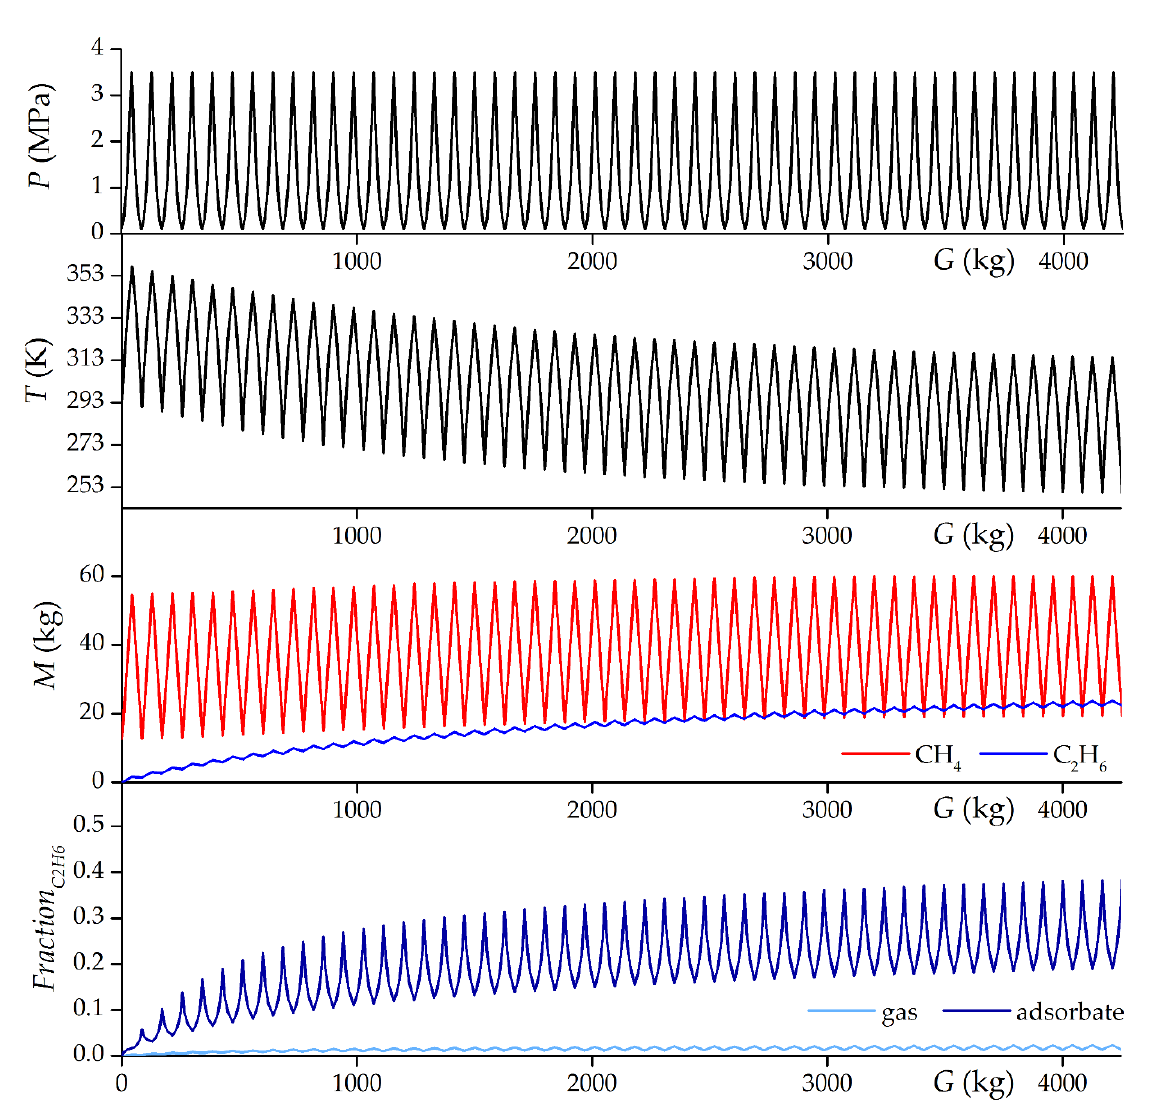
Figure 14. Dependencies of pressure, temperature, and mass of methane and ethane in the adsorption storage with a volume of 1 m 3 based on ACPK adsorbent and the mole fraction of ethane in the gas and adsorbed phases in the “adiabatic” cyclic charging/discharging process and supplied gas with 98% mol. methane and 2% mol. ethane using the IAST simulation results from the cumulative gas exchange since the beginning of the simulation. The first 50 cycles are shown.